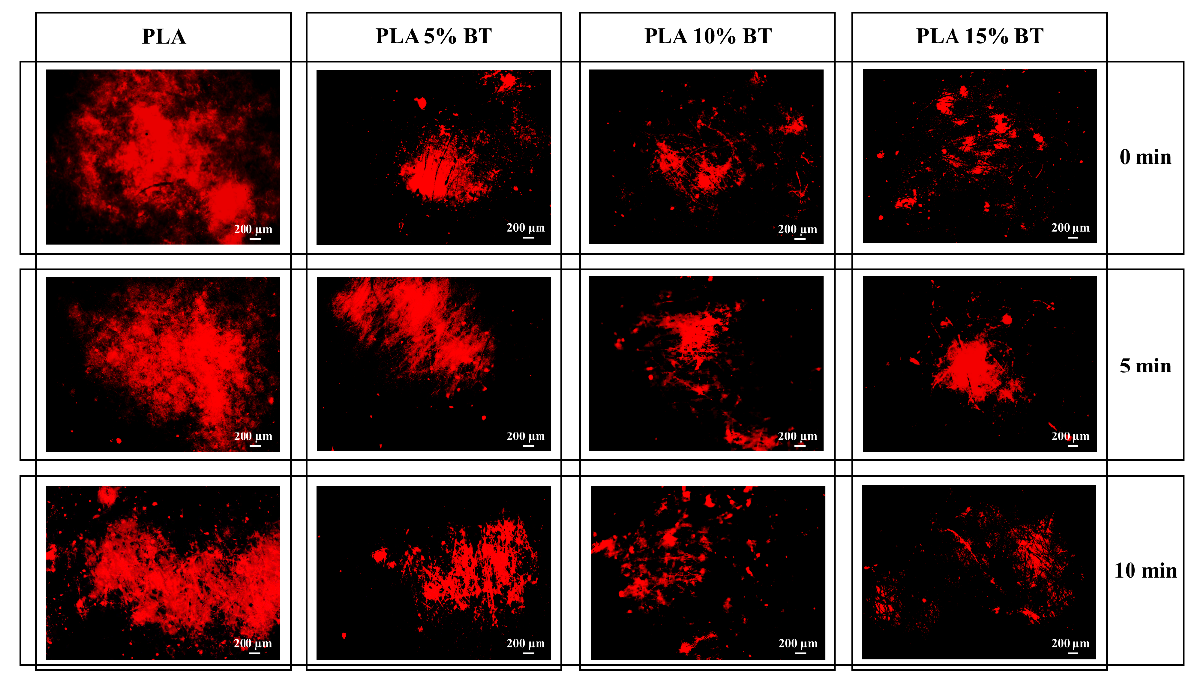
Figure 12. Fluorescence micrographs after CTC staining of S. epidermidis exposed for 24 h to the four substrates. Images were obtained at a 4 × magnification.